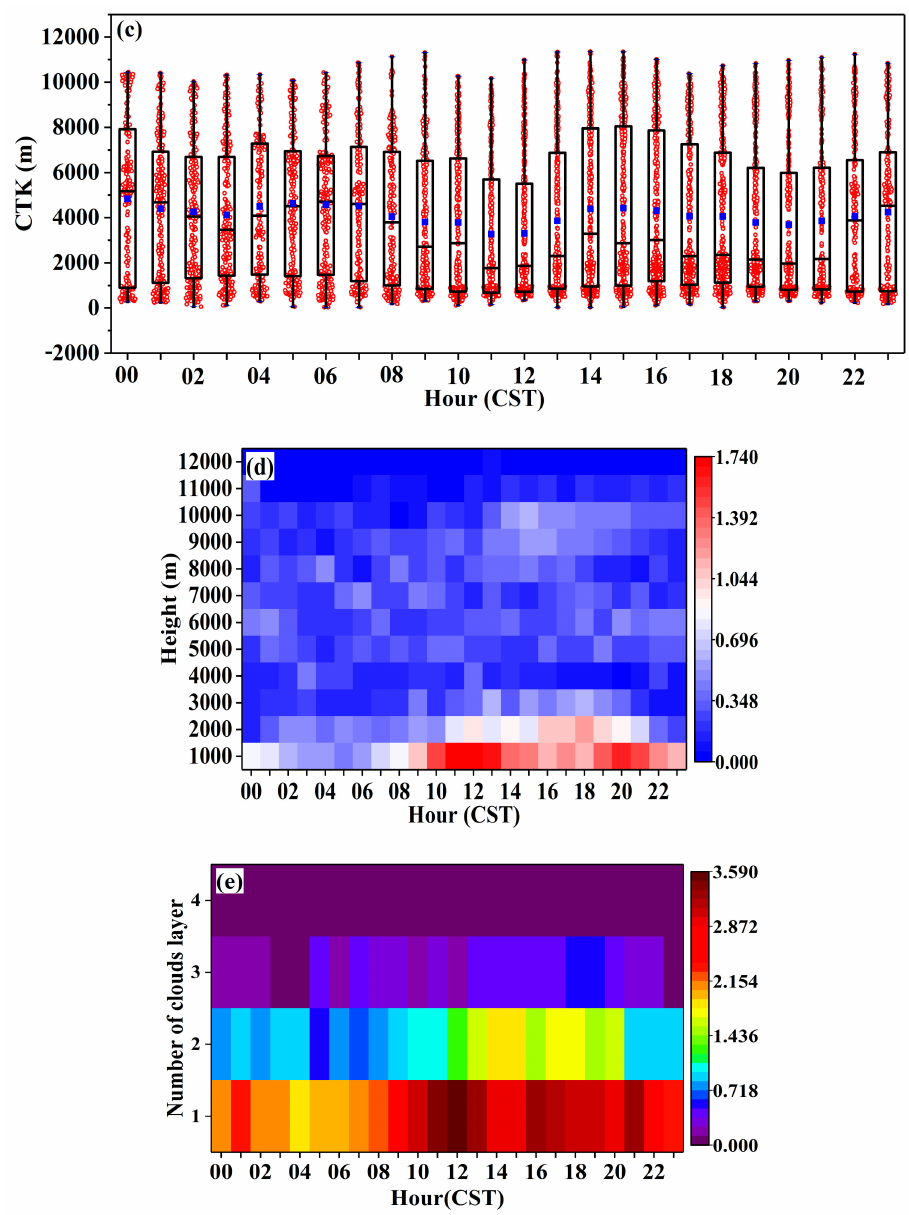
Figure 3. Diurnal variations in ( a ) the cloud base height (CBH) (m), ( b ) the cloud top height (CTH) (m), ( c ) the cloud thickness (CTK) (m), ( d ) the frequency distribution of the CTK, and ( e ) the frequency distribution of the cloud layer number (CLN) during the observation period. On each box, the blue square represents the average, the central crossbar indicates the median, and the bottom and top edges of the box indicate the 25th and 75th percentiles, respectively. The black whiskers extend to the maximum and minimum of the data points, respectively. The positions of the purple and green vertical lines are midday and midnight in Figure 3a,